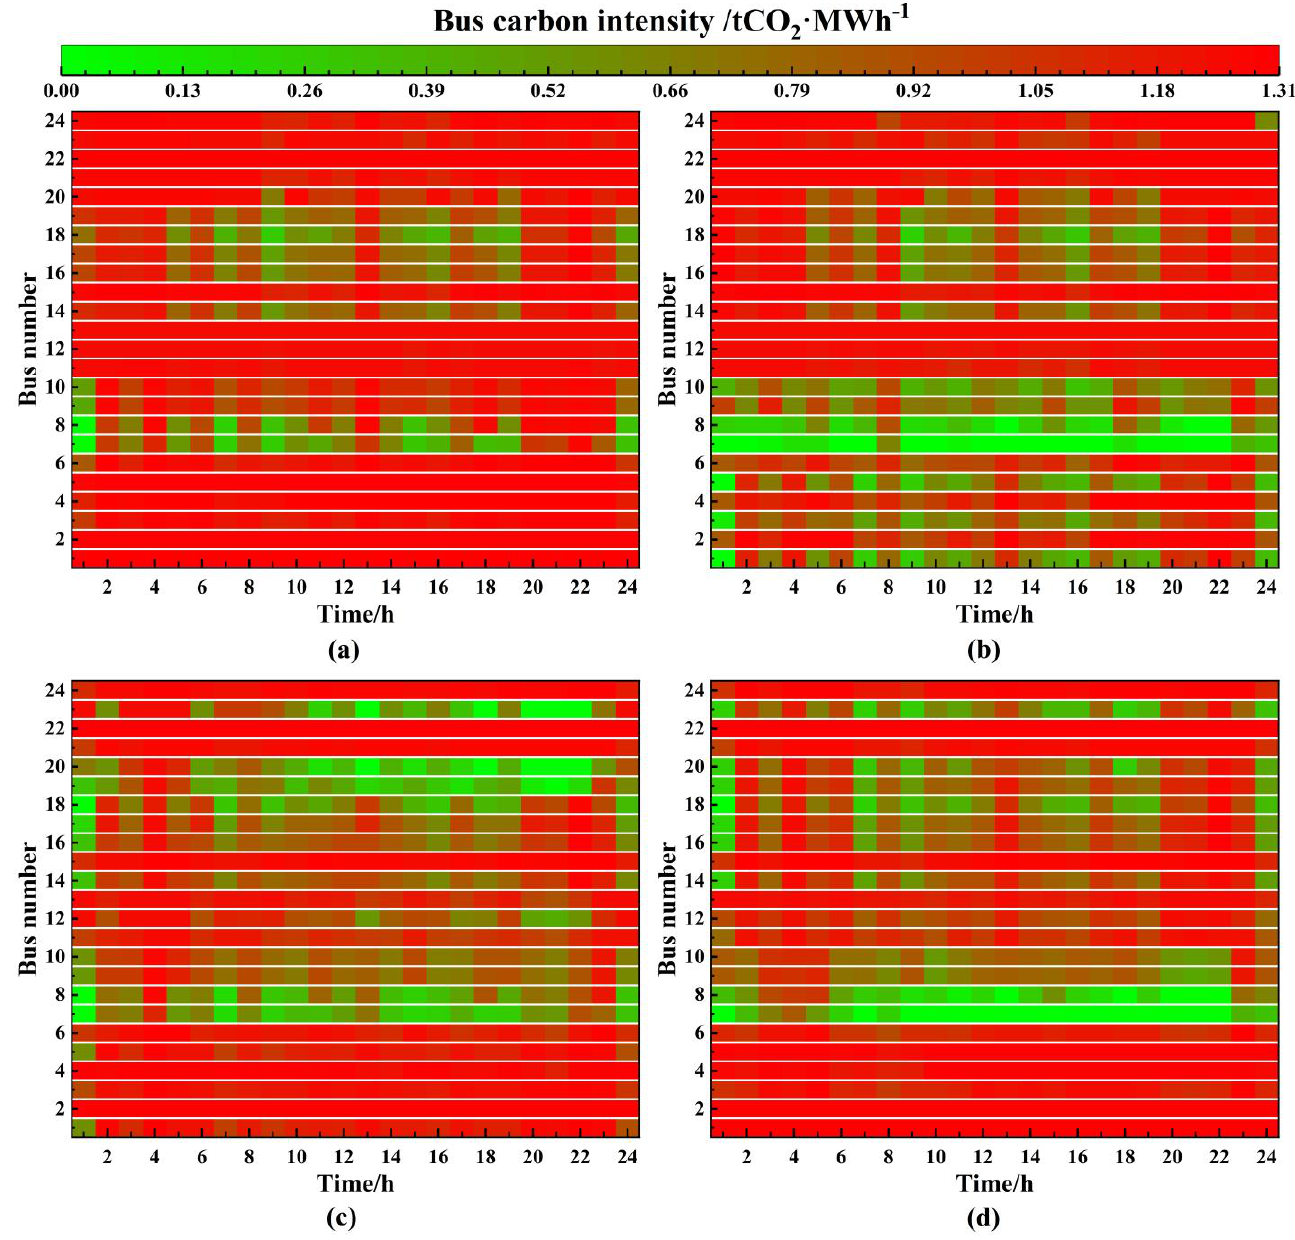
Figure 11. ( a ) Expectation of bus carbon intensity of the pre-planning system; ( b ) expectation of bus carbon intensity in Case 4; ( c ) expectation of bus carbon intensity in Case 5; ( d ) expectation of bus carbon intensity in Case 6.